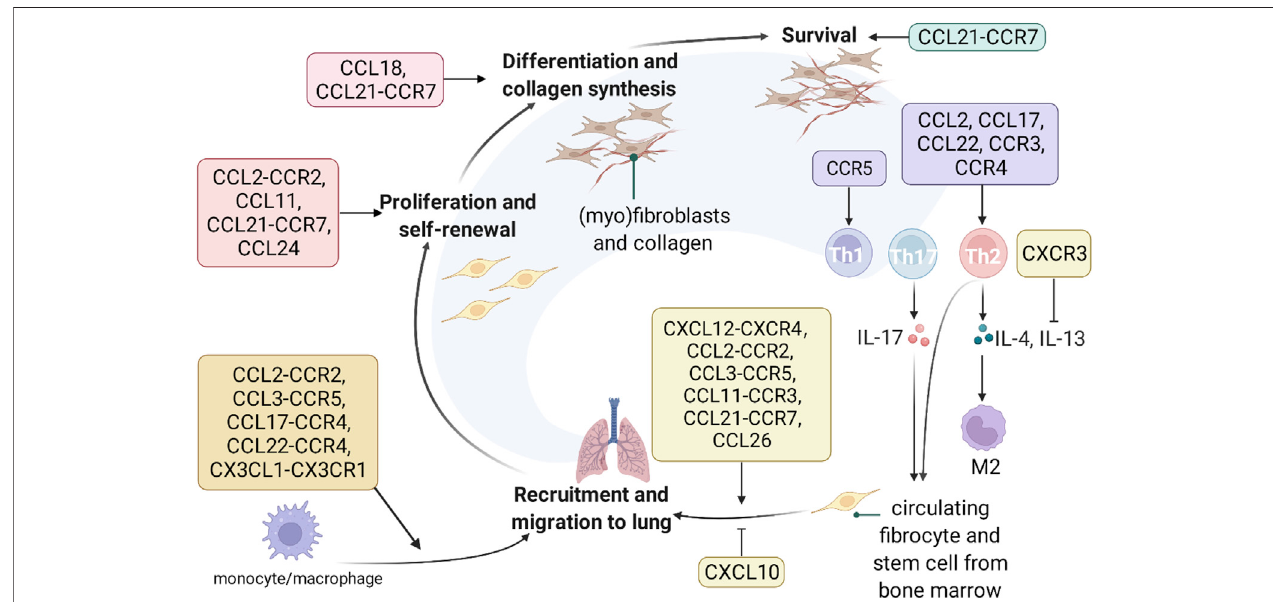
FIGURE 3 | The role and underlying mechanisms of chemokines in IPF. Chemokines are involved in recruitment, proliferation, differentiation, collagen synthesis, survival of fi broblasts, regulation of type 1 and 2 immune balance, and recruitment of monocytes and macrophages.